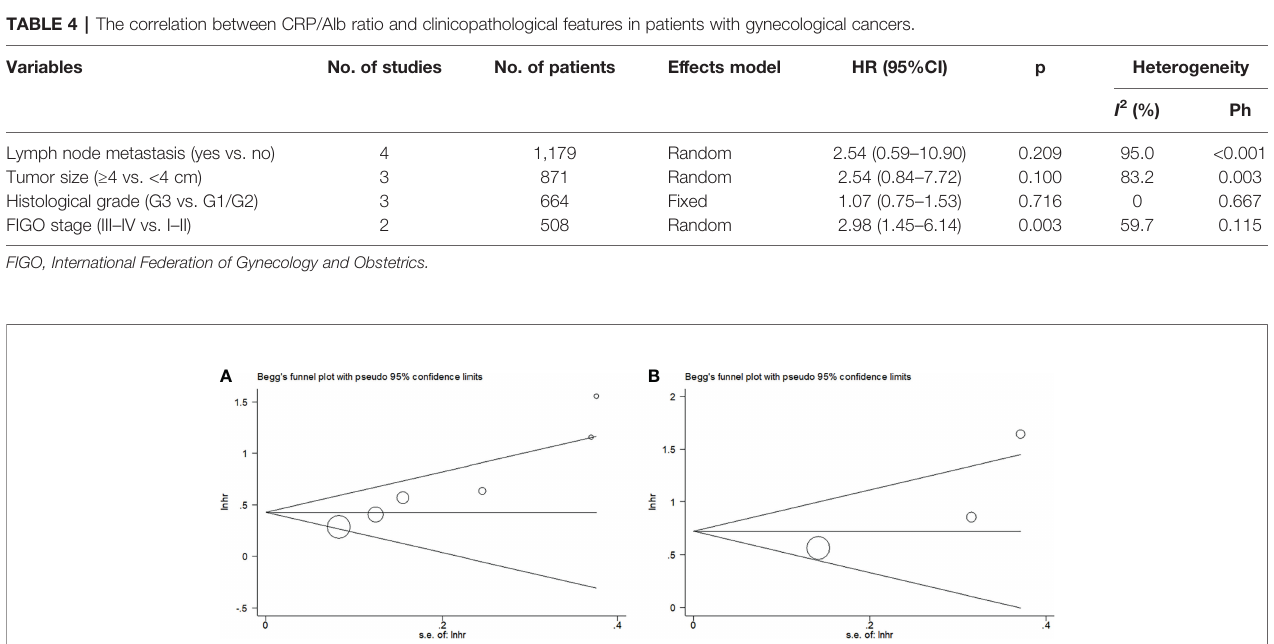
FIGURE 5 | Publication bias tested by funnel plots in this meta-analysis. (A) OS; (B)